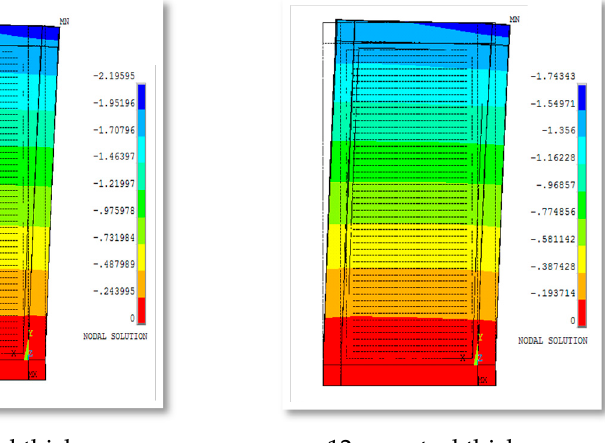
Figure 14. Lateral displacement of group 2.